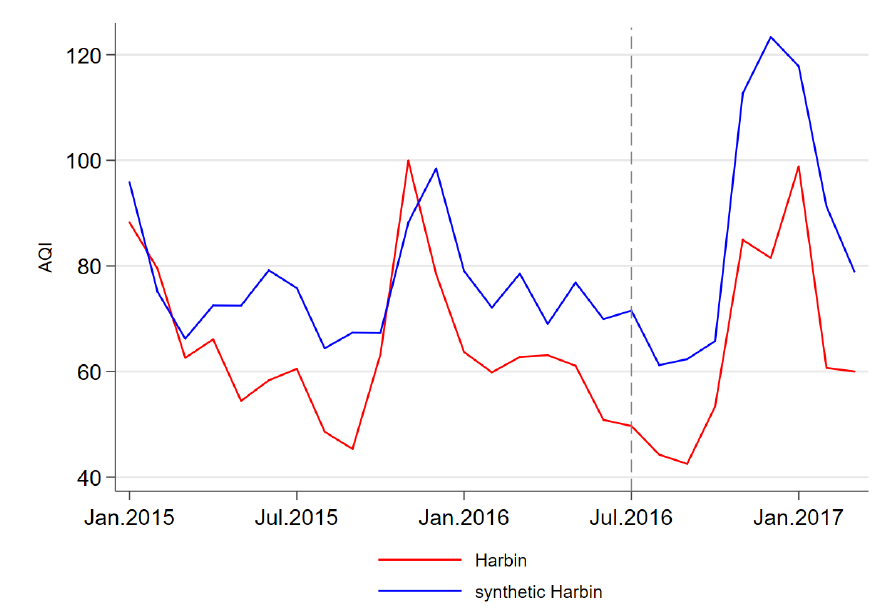
Figure 1. Trends in AQI: Harbin and synthetic Harbin.